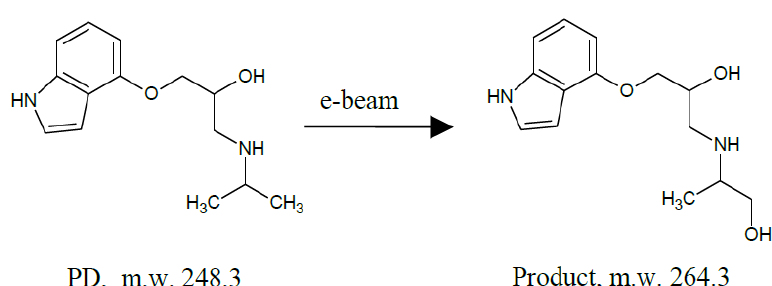
Figure 7. Proposed scheme of radiolytic degradation of pindolol. Table 2. Characterisation of pindolol mass spectra.